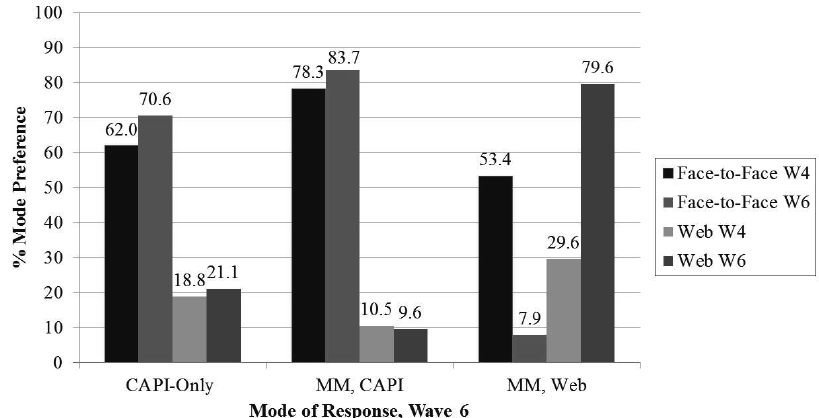
Figure 1 Mode Preference at W4 and W6 by W6 Mode of